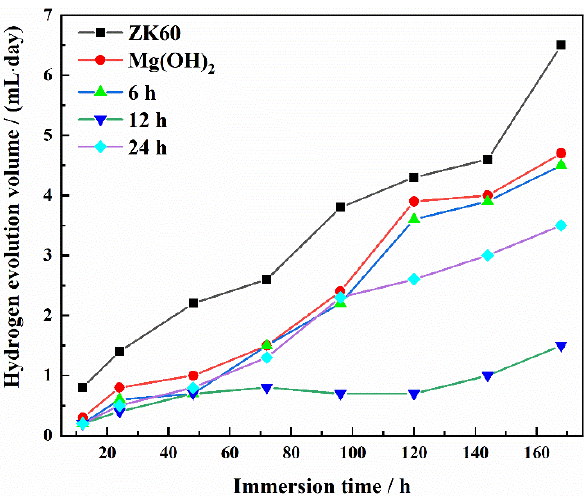
Figure 5. Hydrogen evolution curves of different samples at different immersion times.